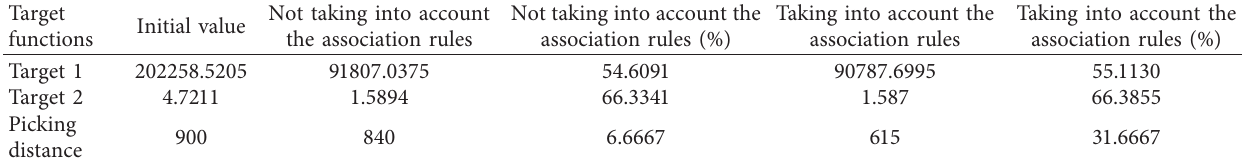
Table 3: Data of the